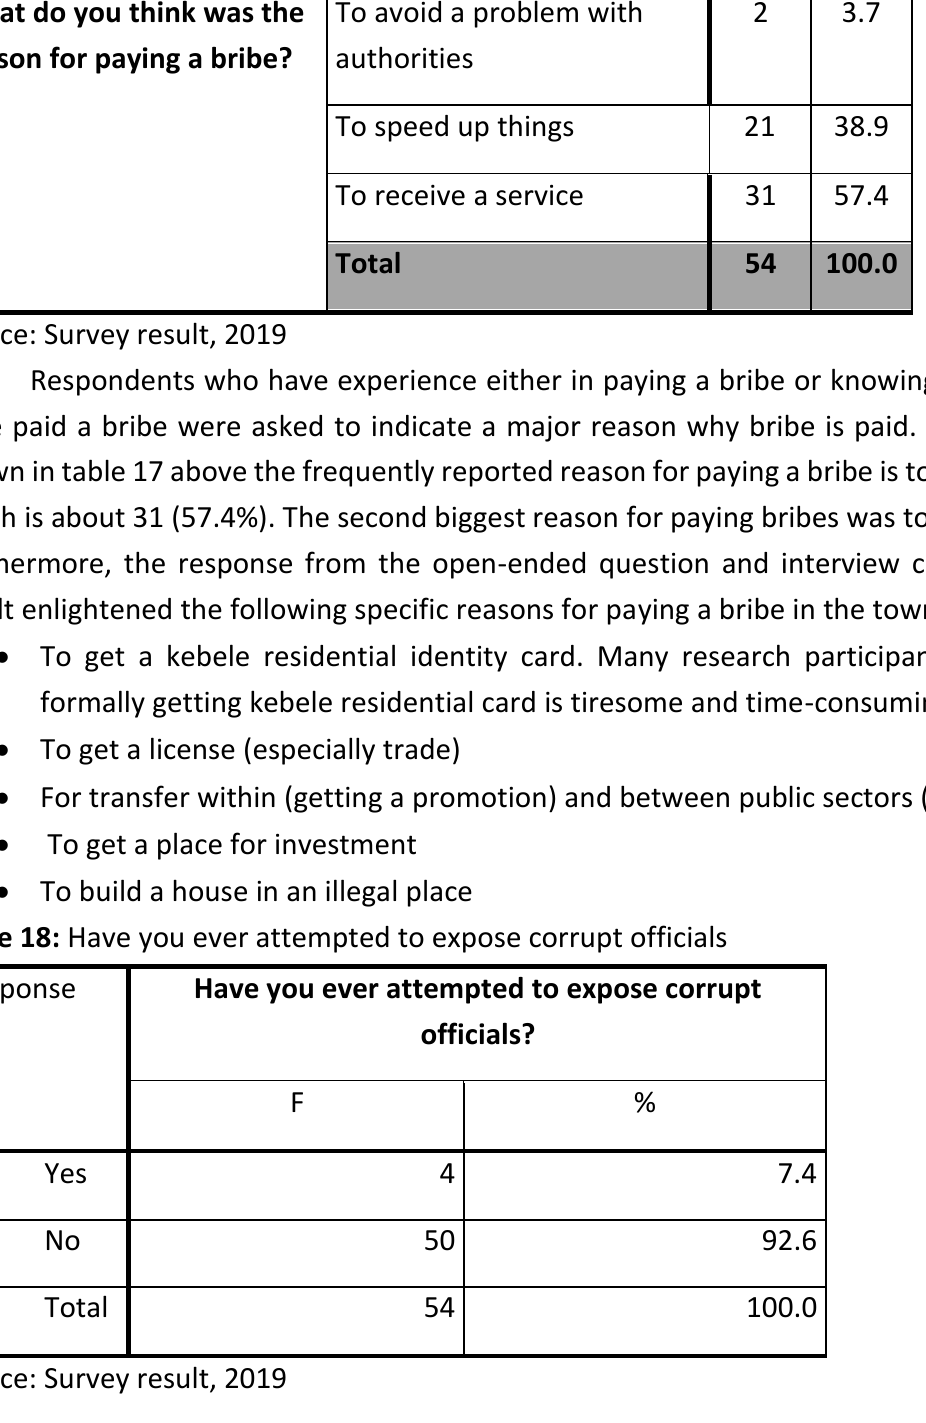
Table 17: Reasons for paying a bribe Item What do you think was the reason for paying a bribe?